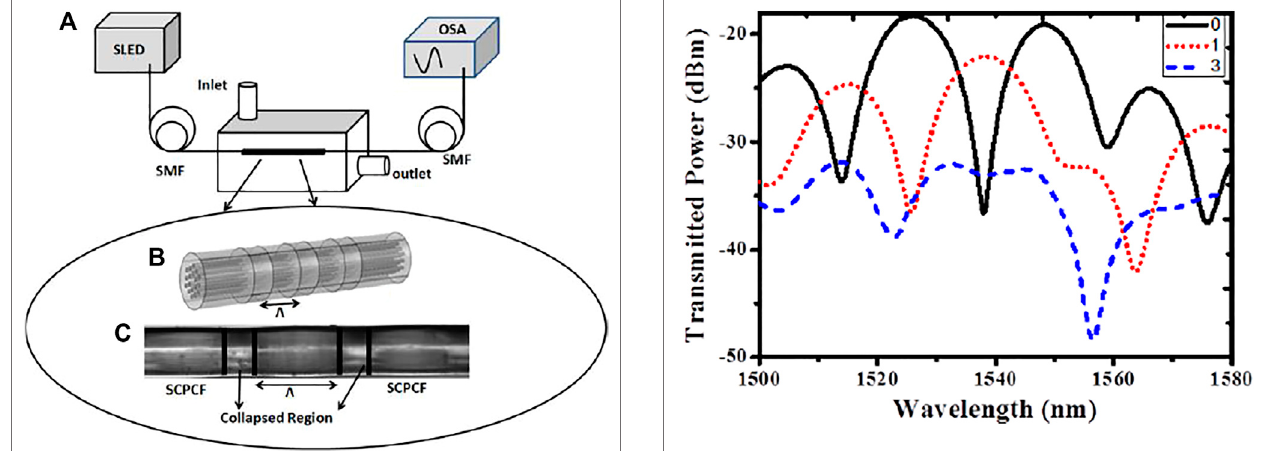
FIGURE 2 | Variation in the interference pattern with increase in number of collapsed